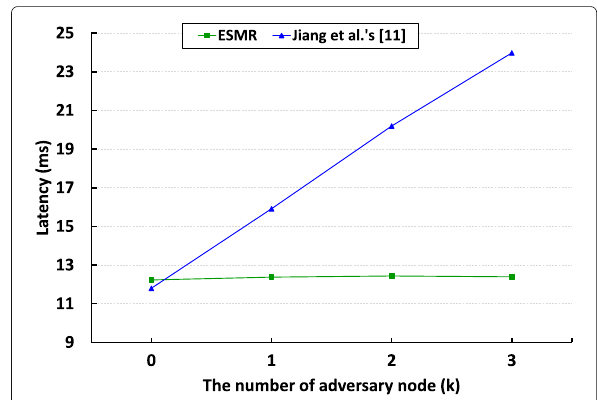
Fig. 11 Average reauthentication latency under DoS attacks based on unconditional